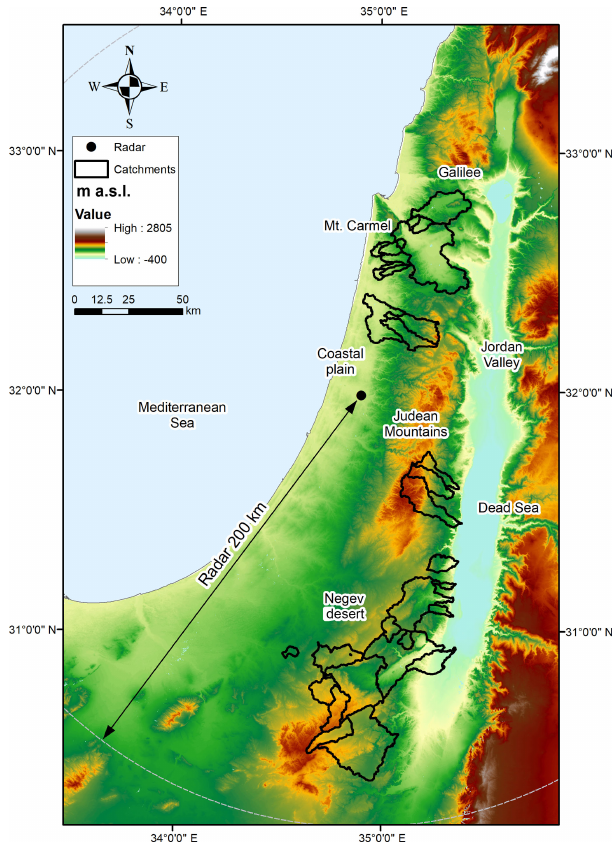
Figure 2. Study area and the outline of the catchments analyzed.